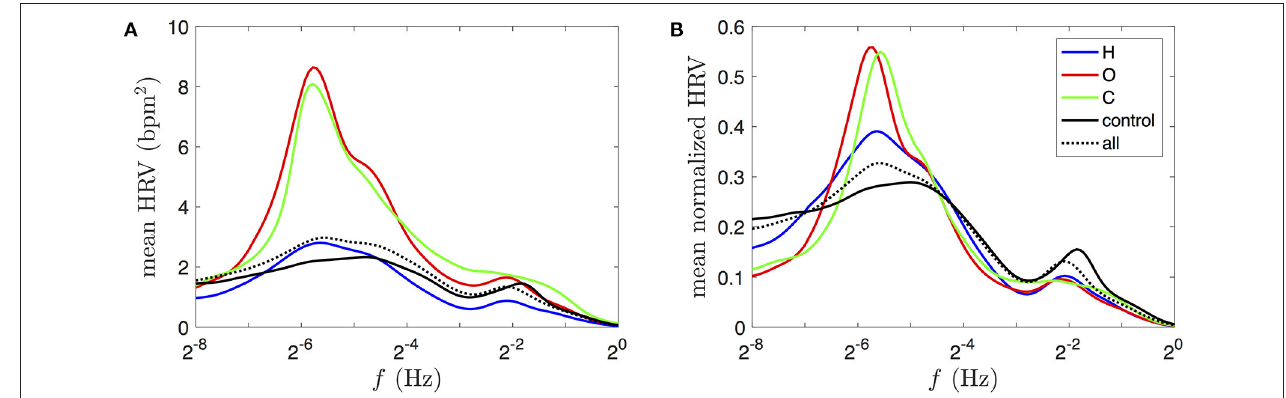
FIGURE 12 | Comparison of typical HRV power spectral densities, obtained from the full database shhs2 . (A) Power log-frequency density of the HRV signal, in bpm 2 , obtained by averaging its squared CWT in time (see Equation 6) over the selected time durations for the same subject groups as those used for Figure 11 (using the same color coding). (B) Time-averaged spectra, normalized for each subject prior to the group average (weighted by individual durations). The heart rate signals are estimated for each subject’s ECG from the corrected RR